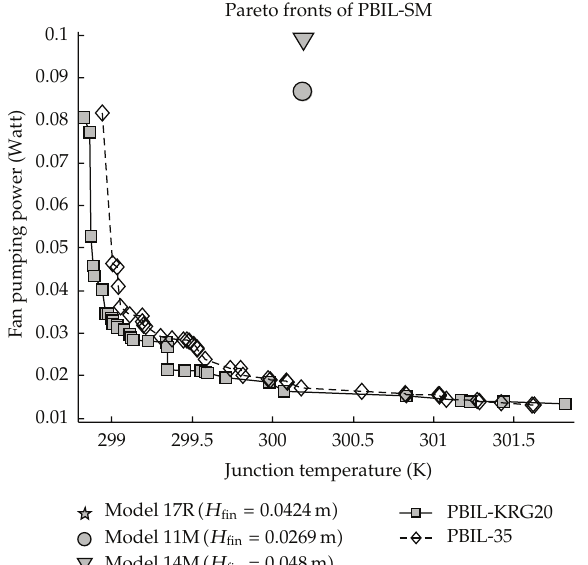
Figure 7: PBIL-KRG20 versus PBIL35 zoom-in of Figure 6.